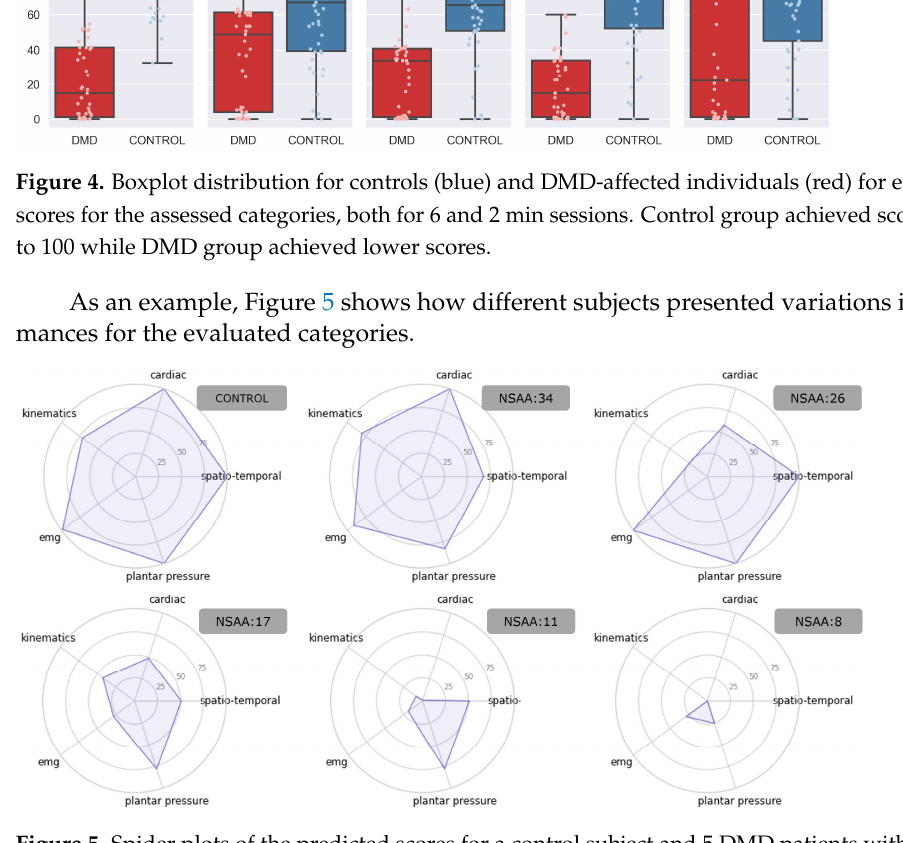
Figure 5. Spider plots of the predicted scores for a control subject and 5 DMD patients with different levels of affliction. As the NSAA scores decrease, so do the scores. However, these reductions are not uniform among categories, being highly dependent on the subjects. uniform among categories, being highly dependent on the